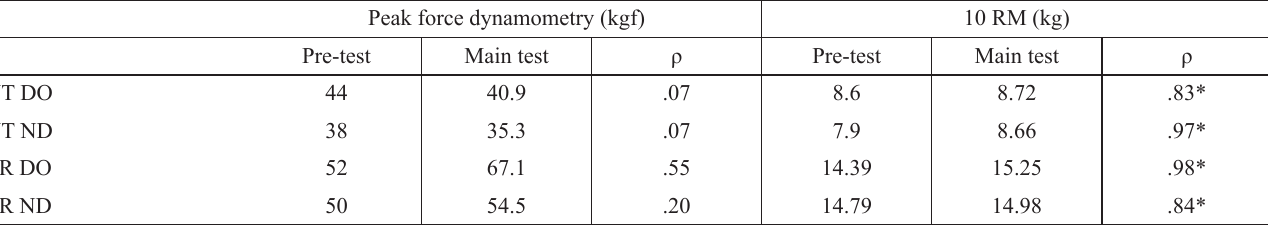
2. Median values and statistical correlation between the values obtained in the preliminary and main tests for maximum grip dynamometry and the 10 RM test applied to the brachial biceps muscle.